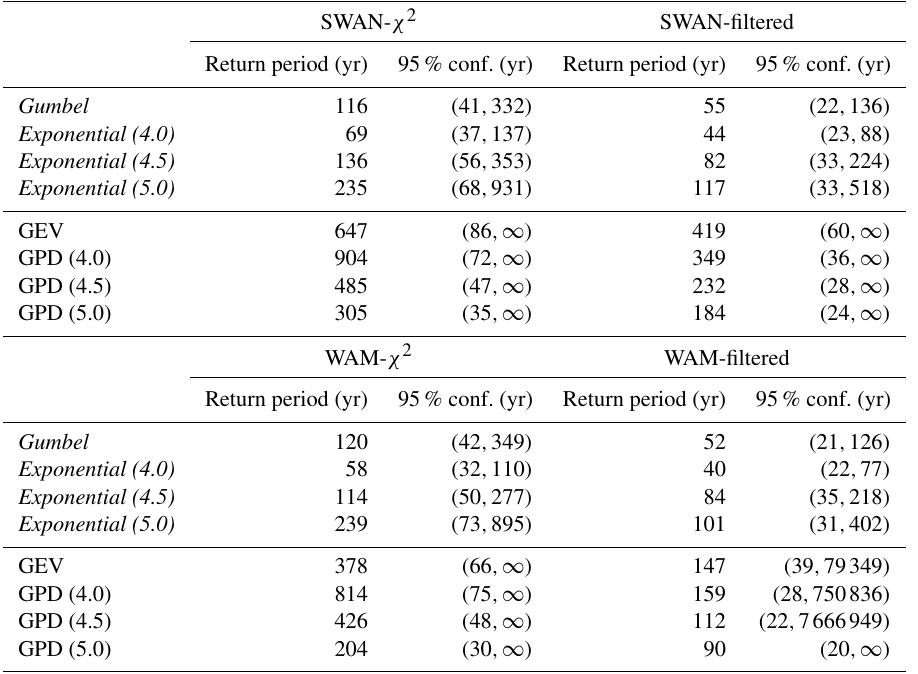
Table 3. The estimated return period of the maximum significant wave height at the Bothnian Sea wave buoy during the storm using block maxima and POT data. The notation GPD (4.0) means a u = 4 . 0m threshold for the POT data. Distributions used for the best estimate and for the return periods in Table 4 are italicised. For a description of the data sets (e.g. WAM- χ 2 ), see Table